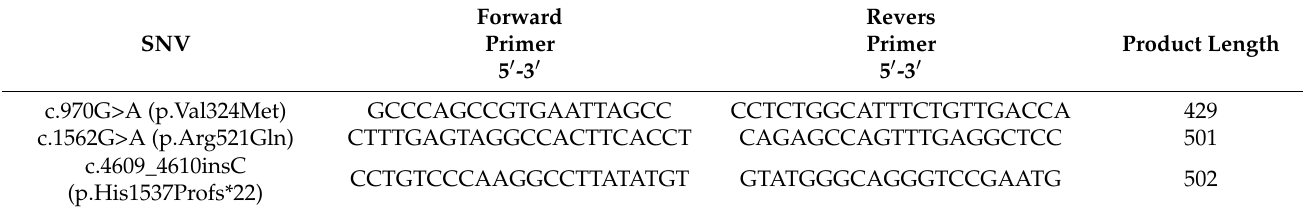
Table 1. Sequencing primers used with the identified